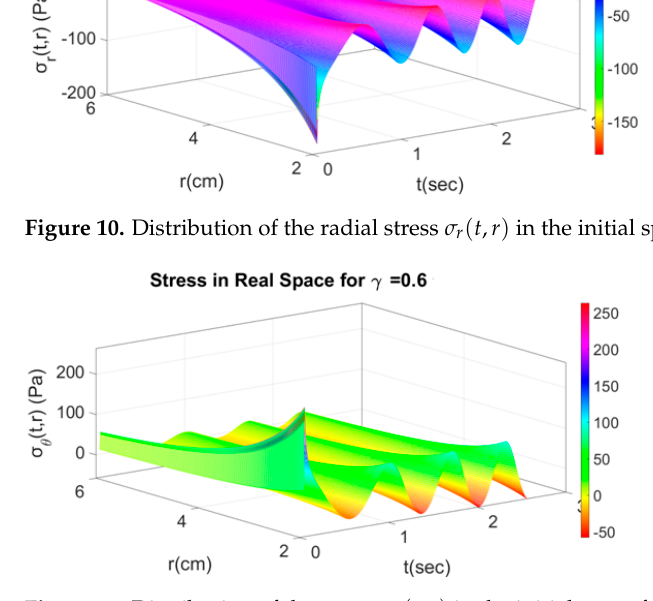
Figure 11. Distribution of the stress 𝜎 (cid:3087) (𝑟, 𝑡) in the initial space for γ = 0.6.